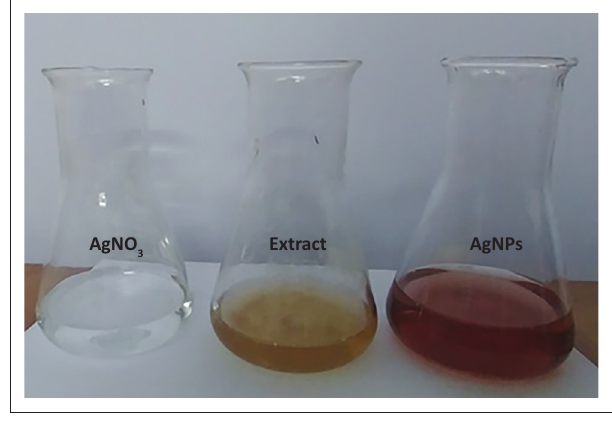
FIGURE 1: Colour change observed in the biosynthesis of silver nanoparticles with methanol leaf extract.